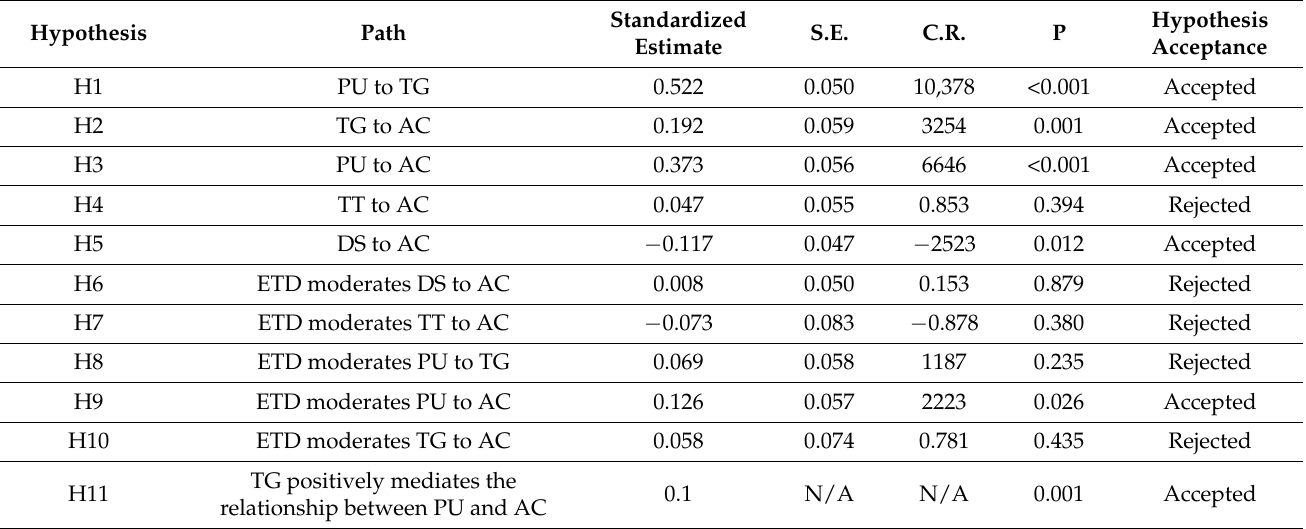
Figure 4. Structural model of IoT technology acceptance. Standardized estimates. Table 4. Standardized and unstandardized model path loadings 1